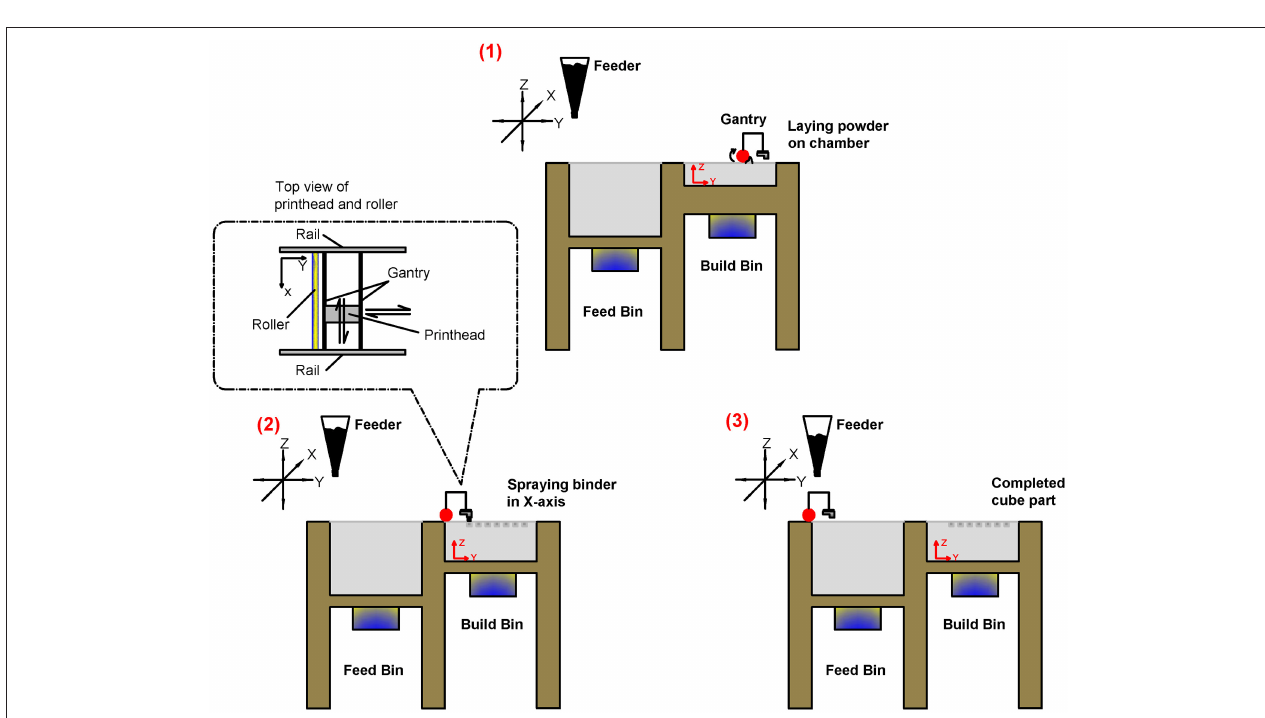
FIGURE 2 | Schematic illustration of the inkjet 3D printing process.